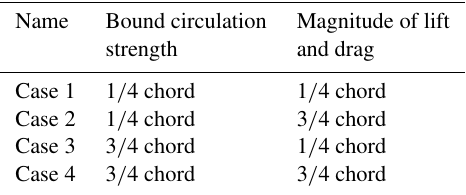
Table 2. The four different choices of the chordwise location for the magnitude of the relative velocity to use for the calculation of the bound circulation strength and the magnitude of the lift and drag force in the two-point approach of the lifting-line